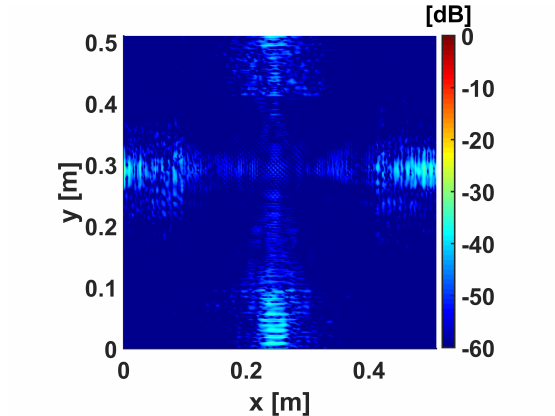
Figure 9. Amplitude ( a ) and angle ( b ) at the top of the wooden particleboard without a flaw. Evaluated with the re-radiation method for the frequency 50kHz, with d x = d y = 2 mm and a grid of the size 256 × 256 points.